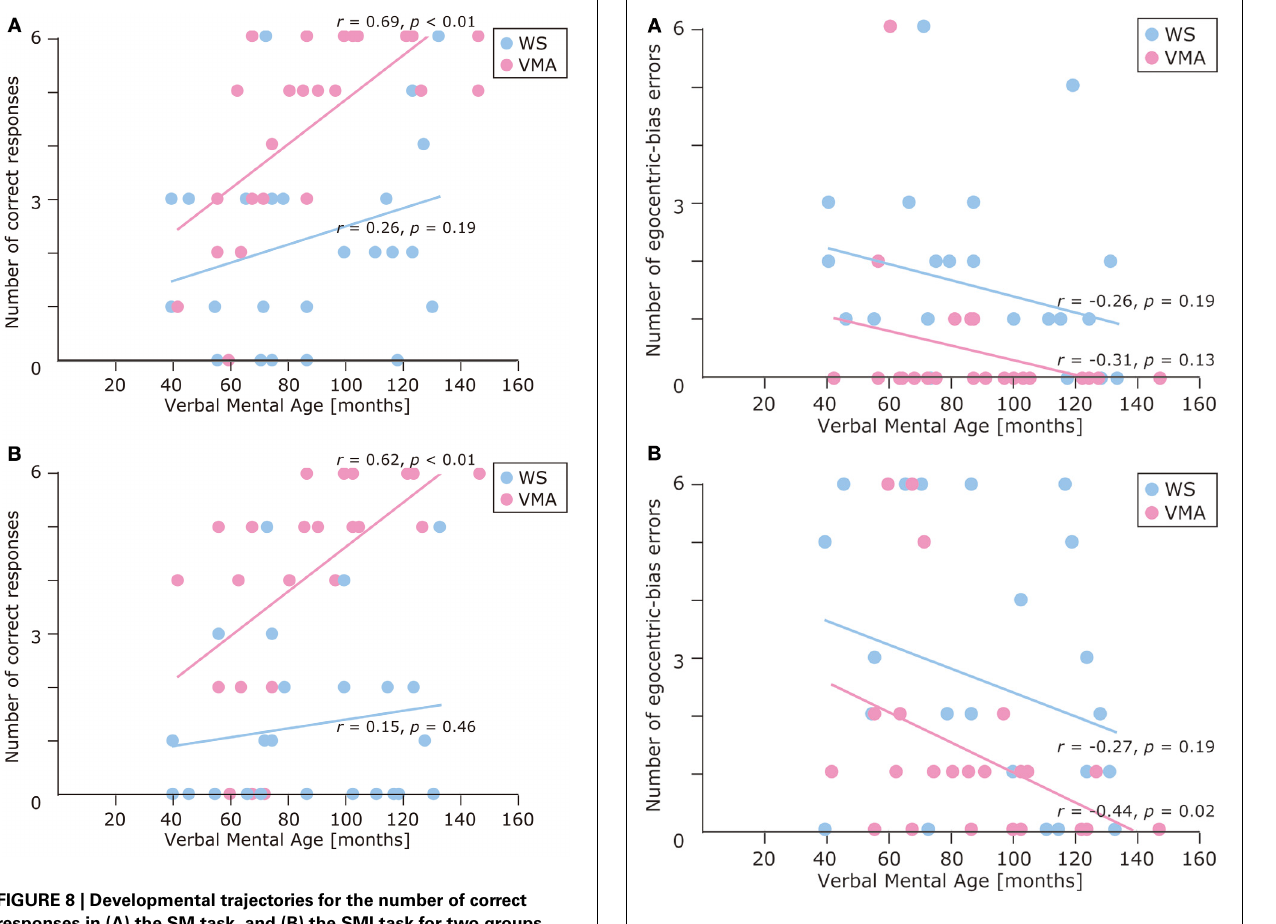
FIGURE 9 | Developmental trajectories for the number of egocentric-bias errors in (A) the SM task and (B) the SMI task for two groups [blue: Williams syndrome (WS) group; pink: verbal mental age-matched (VMA)